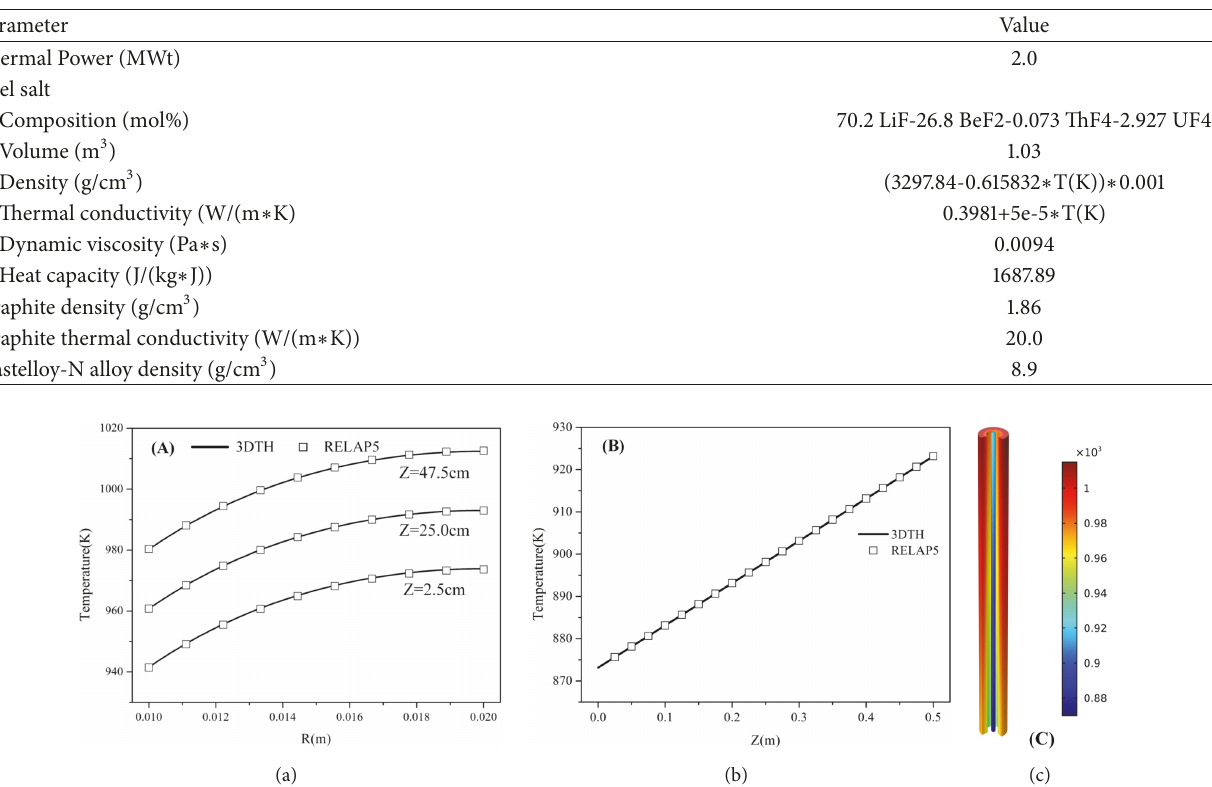
Table 2: Parameters of the 2MW-MSR.